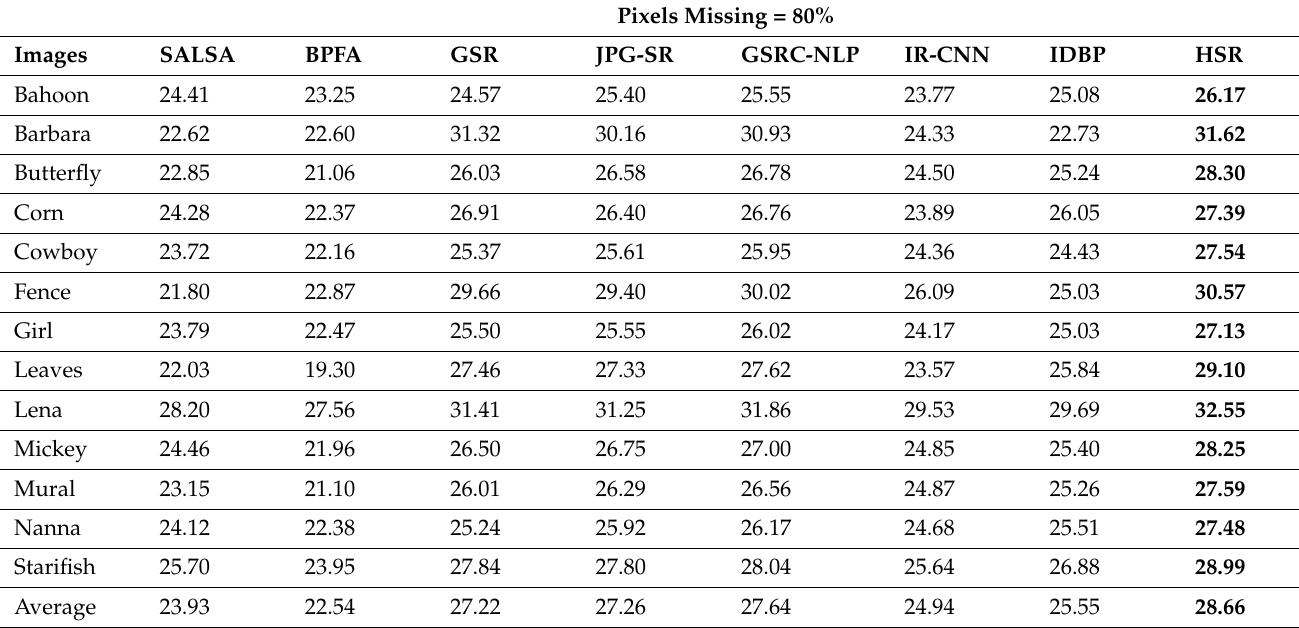
Table 1. PSNR values of our proposed HSR model and other comparison models after image restoration with pixels missing rate 80%.